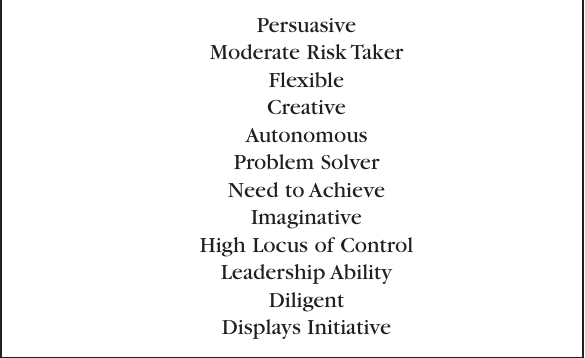
Figure 1. Entrepreneur Qualities and Traits Source: Adapted from Erkkila,